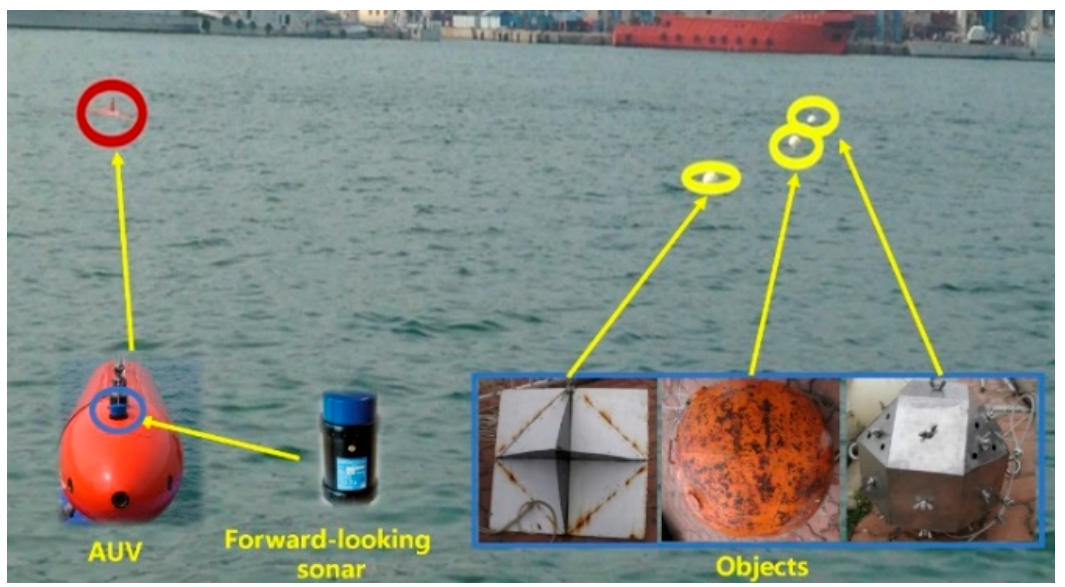
Figure 20. Sea-trial scene.